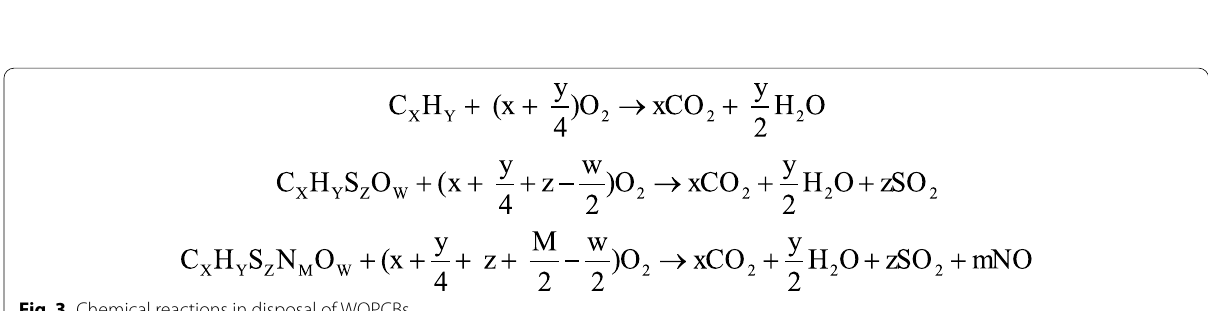
Fig. 3 Chemical reactions in disposal of WOPCBs